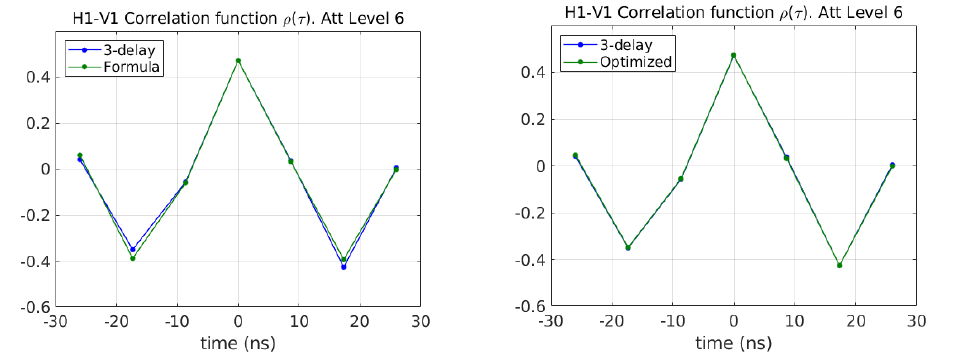
Figure 11. Correlation function measured at different delays. On the left, it is compared with the theoretical formula using initial parameter values. On the right, after optimizing the parameters. In the plot on the right, the result of a numerical optimization of these parameters is shown. In this case, both lines just superimpose each other, indicating that the correct parameters have been found. Parameters for the fringe washing function shape are then computed as indicated after Equation (46).